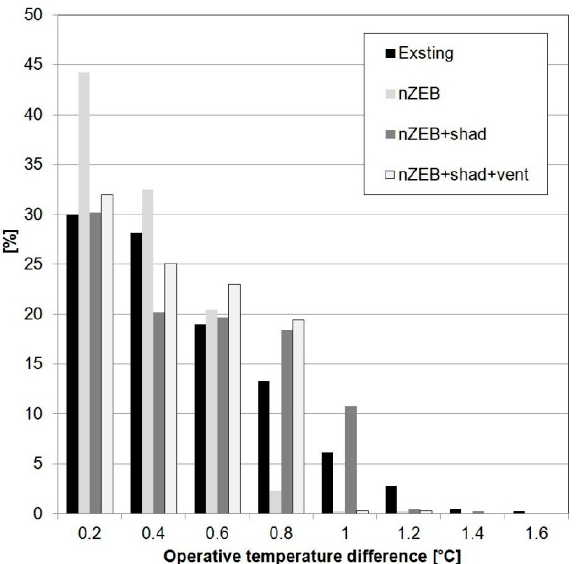
Figure 3. Frequency distribution of operative temperature differences between south-oriented classrooms at intermediate and upper floors in Milan.